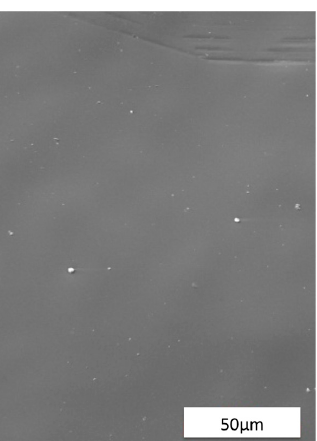
Figure 2. SEM image of sample TiBN1200, representative of the homogeneity of the top surface.